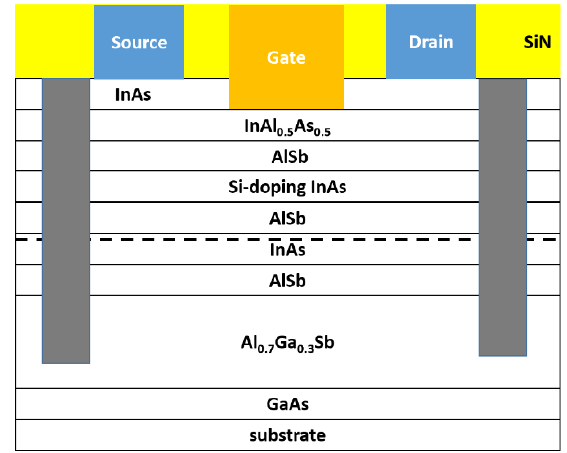
Figure 1. Structure of InAs / AlSb high electron mobility transistor (HEMT).